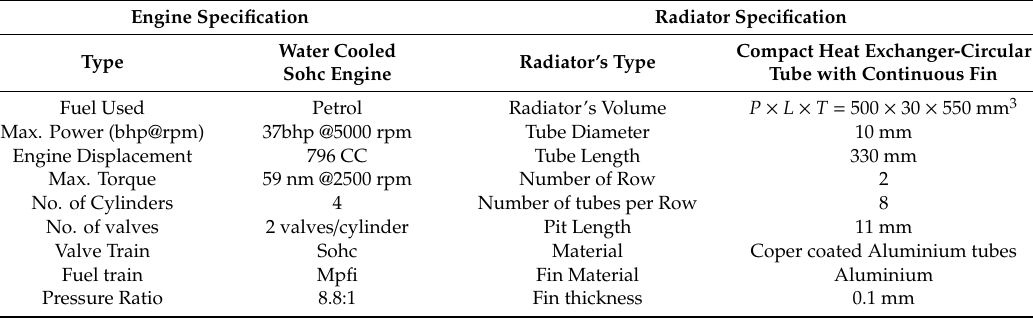
Figure 3. Experiment-Radiator Thermal analysis. Table 3. Engine and Radiator Specification.